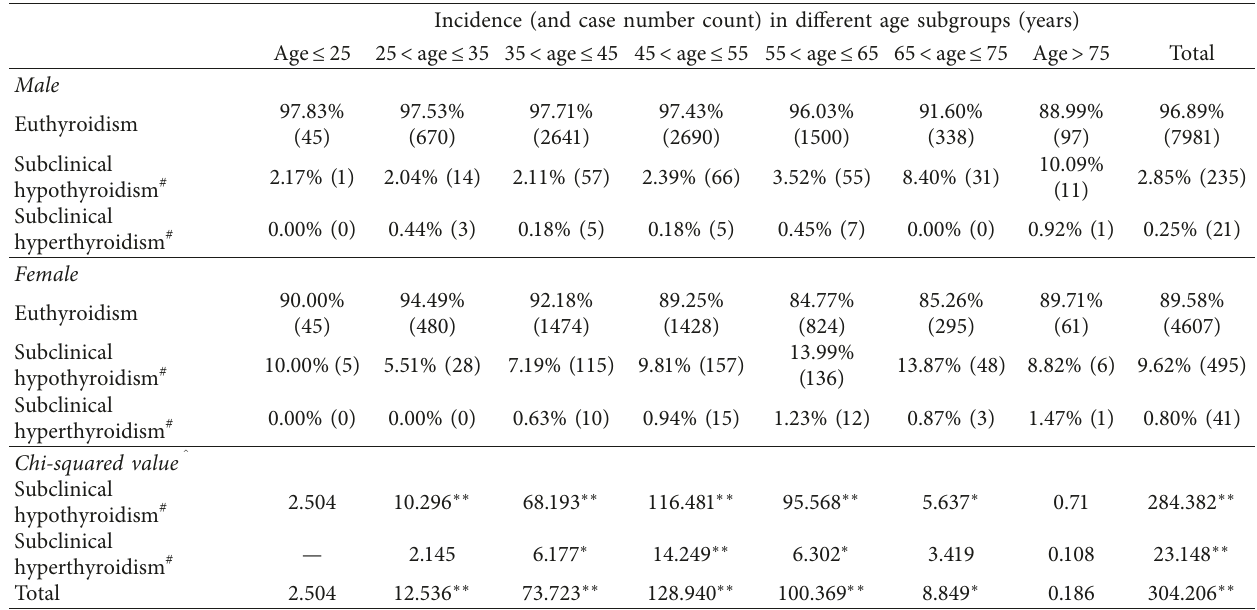
Table 2: Incidence of subclinical hypothyroidism and subclinical hyperthyroidism on different genders according to age. Incidence (and case number count) in different age subgroups (years)